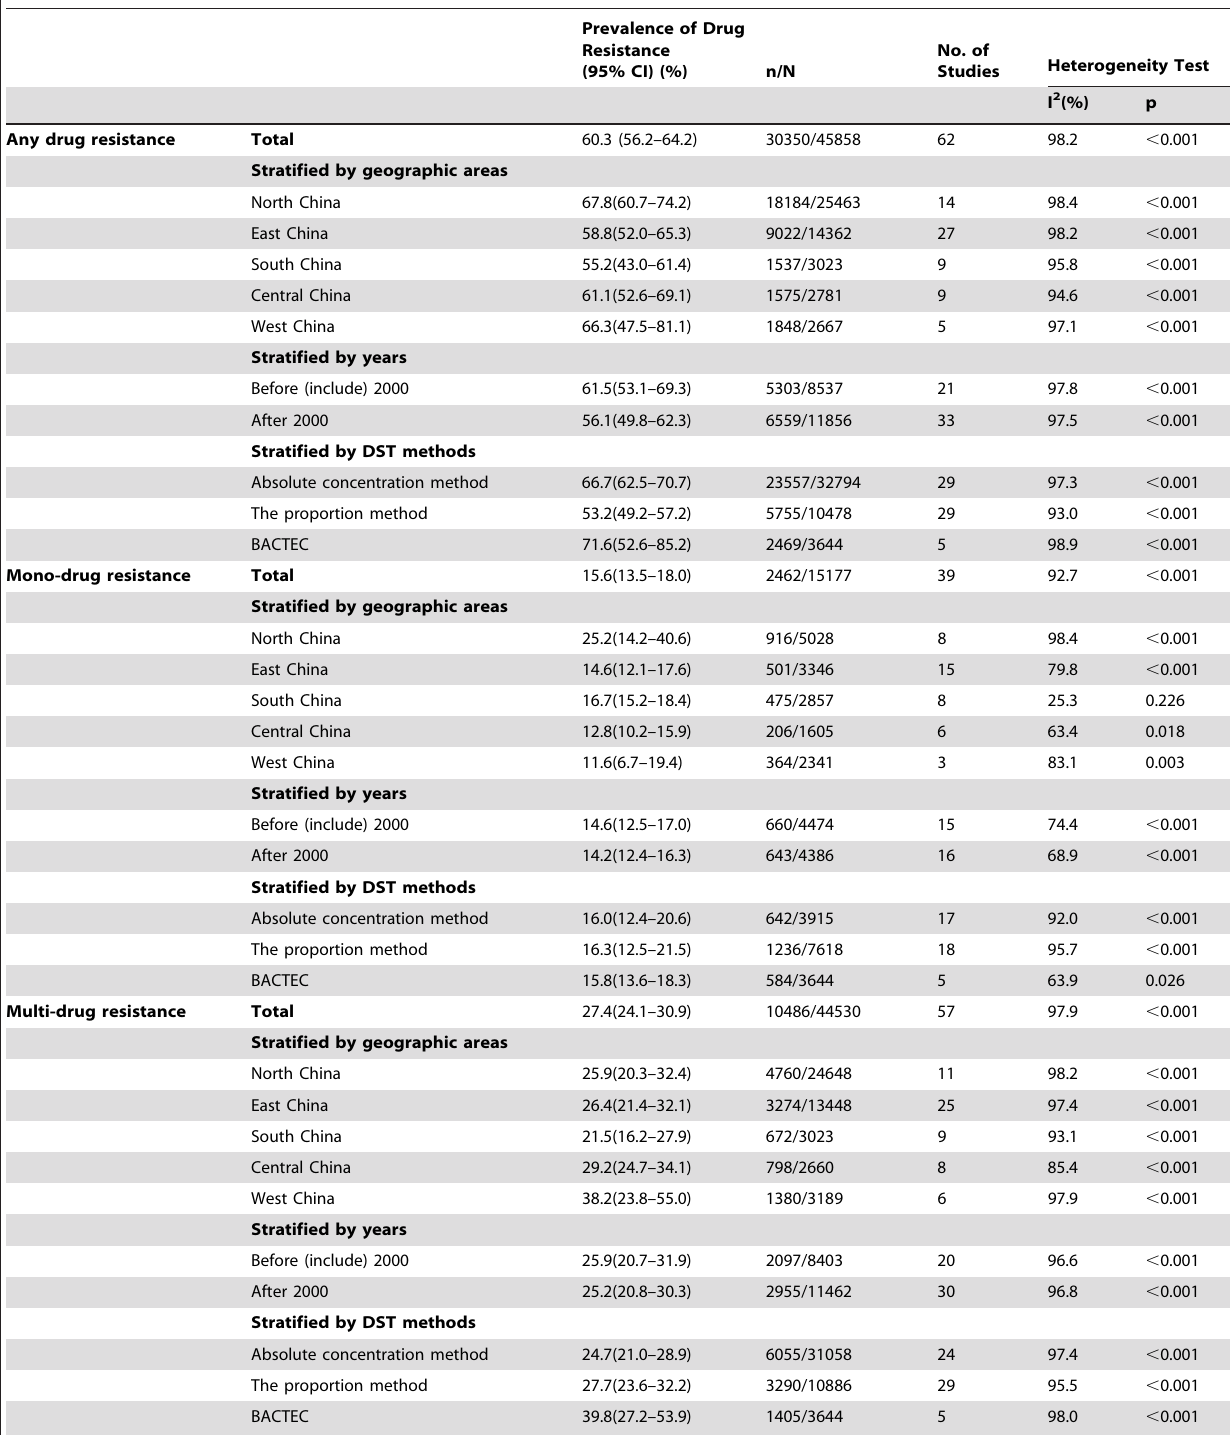
Table 2. Status of drug-resistant tuberculosis among previously treated cases in China.